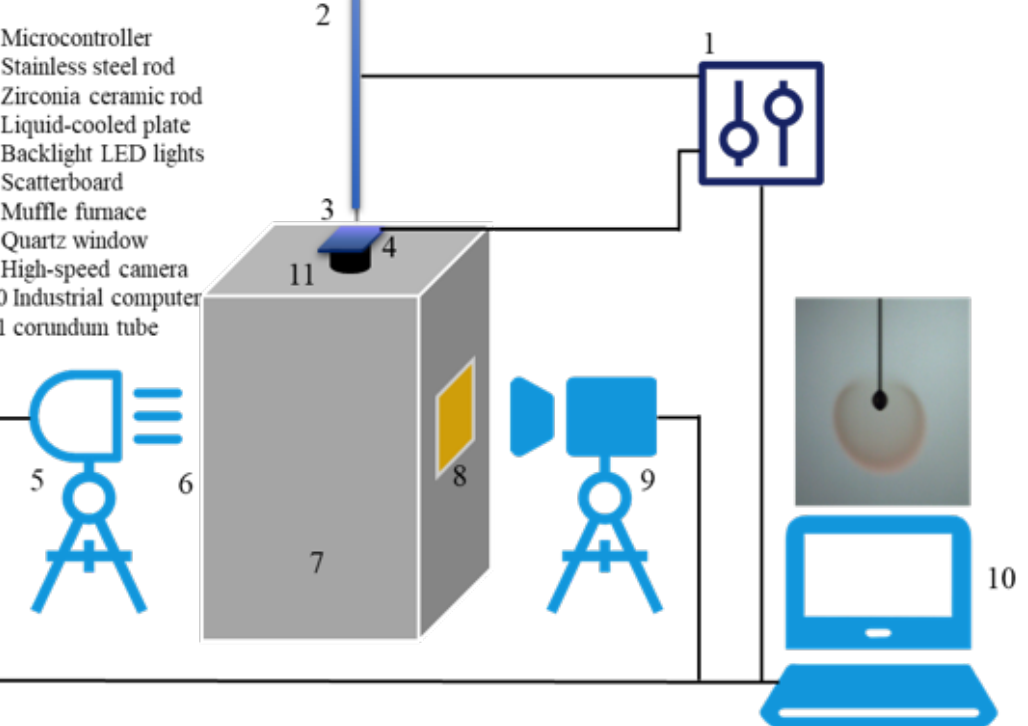
Figure 1. Schematic diagram of the experimental apparatus.